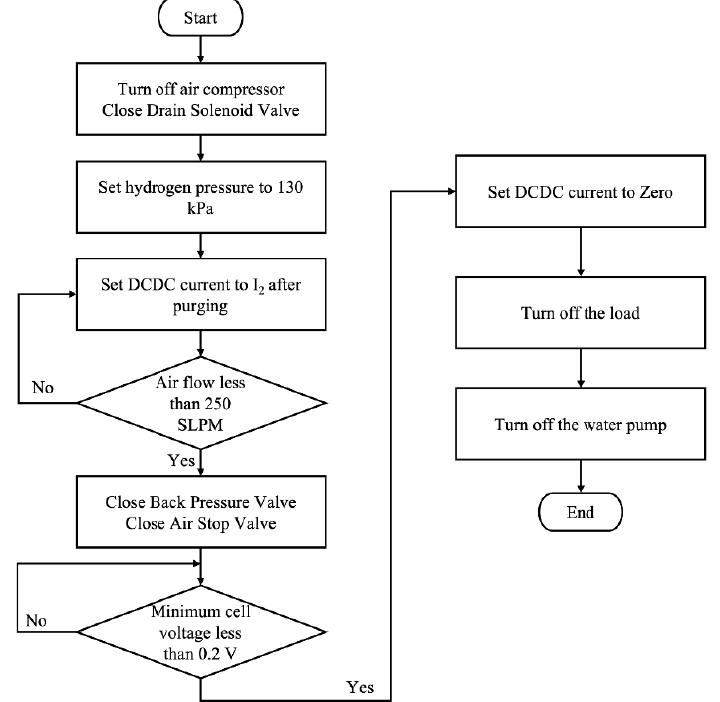
Figure 2. The experimental flow chart of unoptimized shutdown strategy.